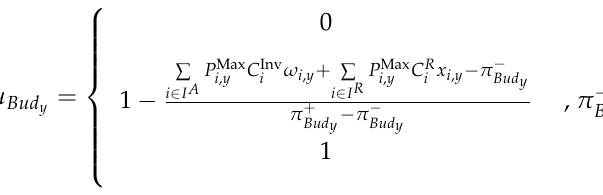
Figure 4. Fuzzy membership function for the budget constraint.